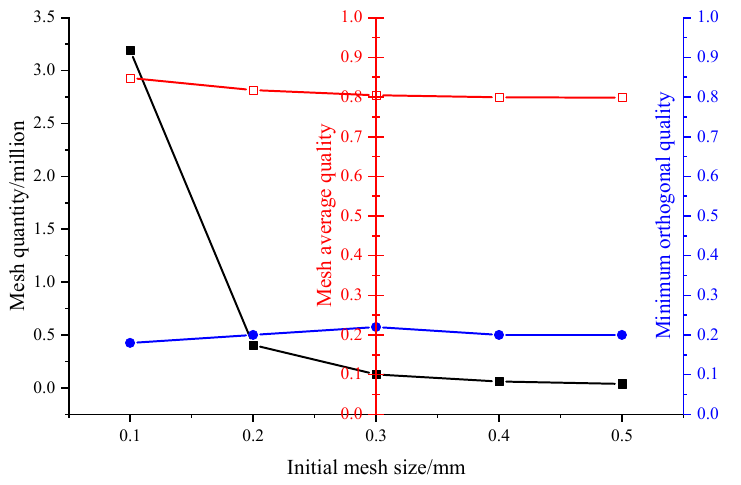
Figure 6. Parameters of initial mesh with different sizes: Black line: Mesh quantity; Red line: Mesh average quality; Blue line: Minimum orthogonal quality.